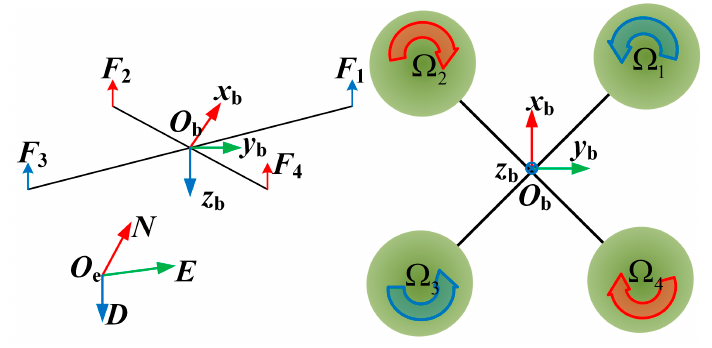
Figure 1. Definition of coordinate Figure 1 . Definition of coordinate frames.